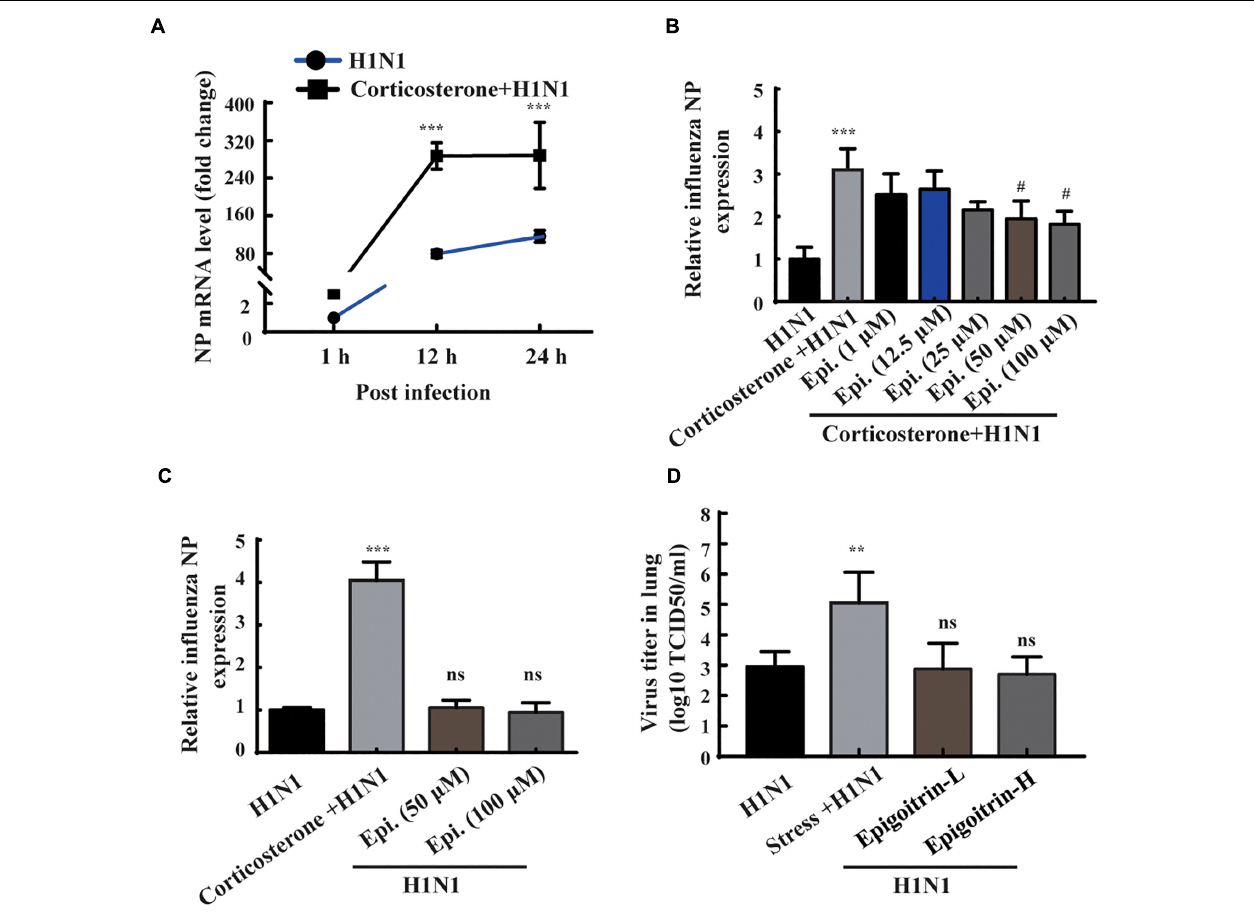
FIGURE 4 | Epigoitrin reduced H1N1 viral expression in corticosterone-loaded A549 cell. (A) A549 cells were treated with or without corticosterone (100 µ M) for 48 h before viral infection and the NP gene expression were measured by RT-qPCR at the indicated time. (B,C) Effects of epigoitrin on the NP gene expression in H1N1-infected A549 cell pretreated with or without corticosterone. (D) Effects of epigoitrin on the viral titers of lungs in stressed or unstressed mice ( n = 4). The difference was considered statistically significant at ∗∗ P < 0.01, ∗∗∗ P < 0.001 vs. H1N1 group; # P < 0.05 vs. corticosterone +H1N1 group; ns, no significance ( P ≥ 0.05) vs. H1N1